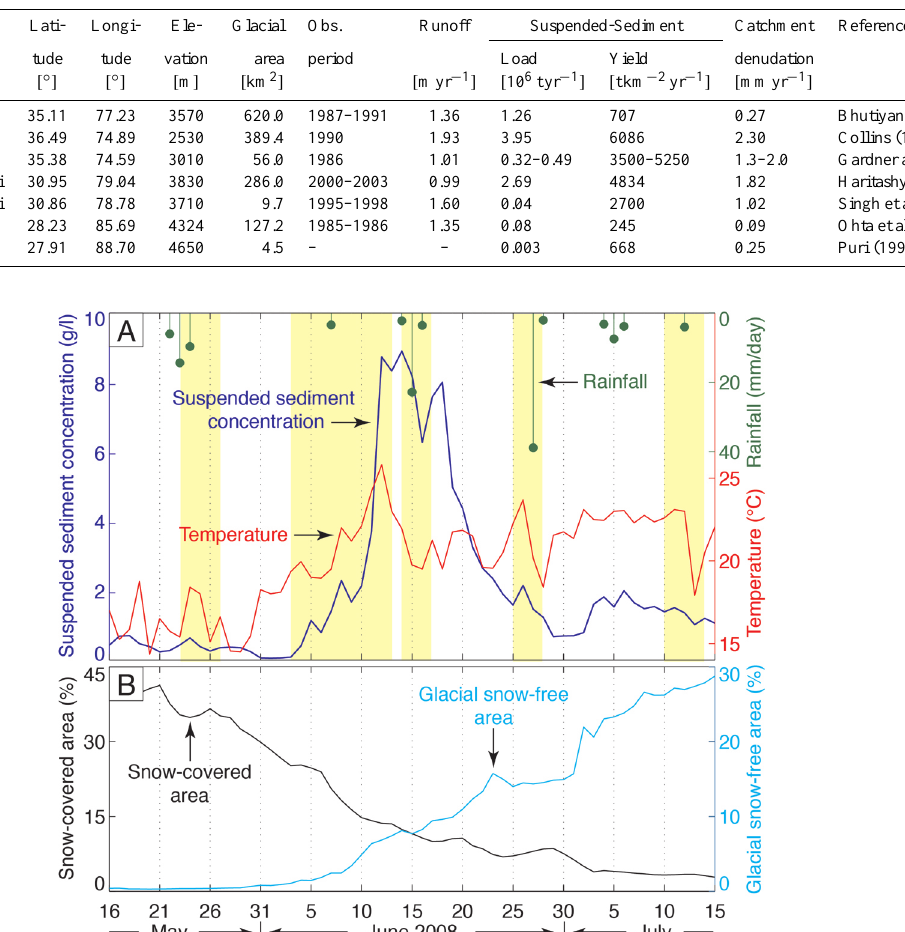
Table 6. Suspended sediment flux in proglacial streams of the Himalaya and Karakorum. The catchment denudation rate is based on a bulk rock density of 2.65gcm − 3 , accounts only for the suspended sediment flux, and relies on the catchment area. Note that the glacial area is always smaller than the catchment area (not shown).